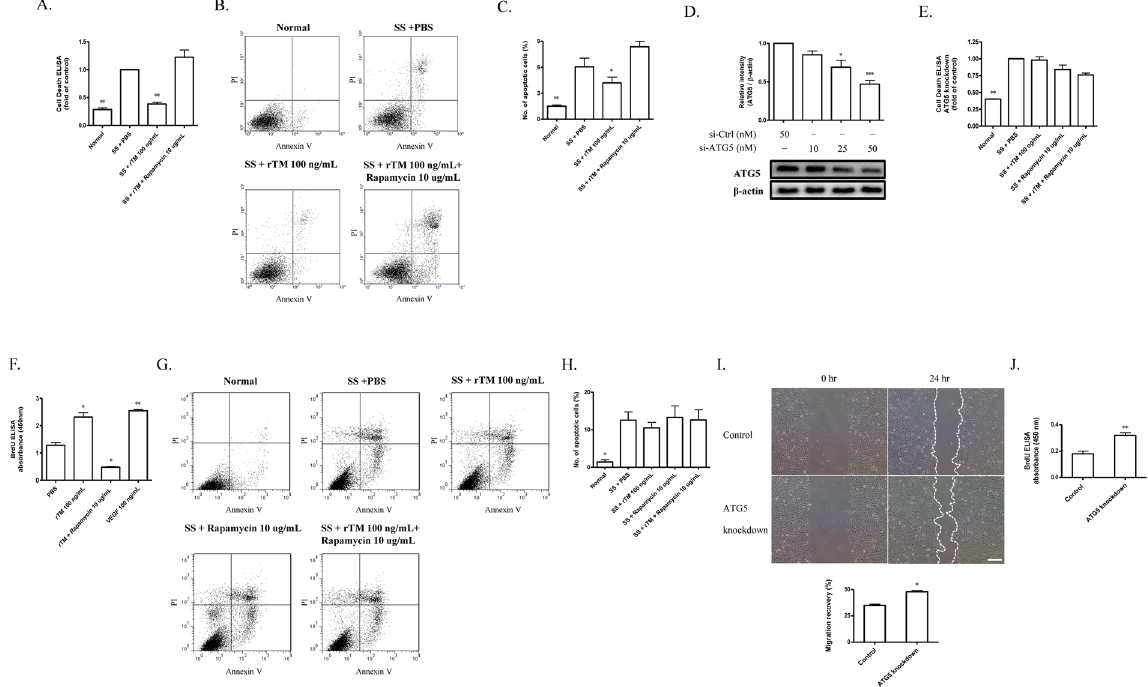
Figure 2. Autophagy plays a role in rTM effect on ECs. ( A and E ) Normal ( A ) and ATG5 knockdown ( E ) ECs received various indicated treatment. Apoptosis was determined with a cell death detection ELISA kit. The data were expressed as absorbance ratios of various indicated treatment to SS + PBS treatment. Data are shown as mean ± SEM (n = 3). ** p < 0.01 vs. cells with SS + PBS treatment. ( B and C ; G and H ) Apoptosis in normal ( B ) and ATG5 knockdown ECs ( G ) was also determined with a FITC annexin V apoptosis detection kit with flow cytometry. The representative pictures from each group were shown ( B and G ). The data were expressed as the percentage of apoptotic cell count (Annexin V-FITC positive and PI positive)/total cell count ( C and H ). All results were obtained from three independent experiments. Data are shown as mean ± SEM (n = 3). * p < 0.05 and ** p < 0.01 vs. cells with SS + PBS treatment. ( D ) ECs were transfected with control siRNA (si- Ctrl) and ATG5 siRNA (si-ATG5). The knockdown efficiency of ATG5 in ECs was measured by western blot. Data are shown as mean ± SEM (n = 3). * p < 0.05 and *** p < 0.001 vs. cells with si-Ctrl transfection. ( F ) Cell proliferation was measured in ECs received various indicated treatment. Data were expressed as BrdU absorbance and shown as mean ± SEM (n = 3). * p < 0.05, ** p < 0.01 vs. cells with PBS treatment. VEGF was used as a positive control. ( I and J ) Migration and proliferation ability were compared between ECs with and without ATG knockdown (control transfection). Representative photomicrographs of the ECs migration during wound healing assay were shown ( I ; left panel). Cultured ECs were wounded with pipette tips. The migration ability was expressed by the percentage of distance at 24 hr/0 hr ( I ; right panel). Bar = 500 μ m. ( J ) Proliferation ability was measured with BrdU assay. Data are shown as mean ± SEM (n = 3). * p < 0.05, ** p < 0.01 vs. cells without ATG5 knockdown